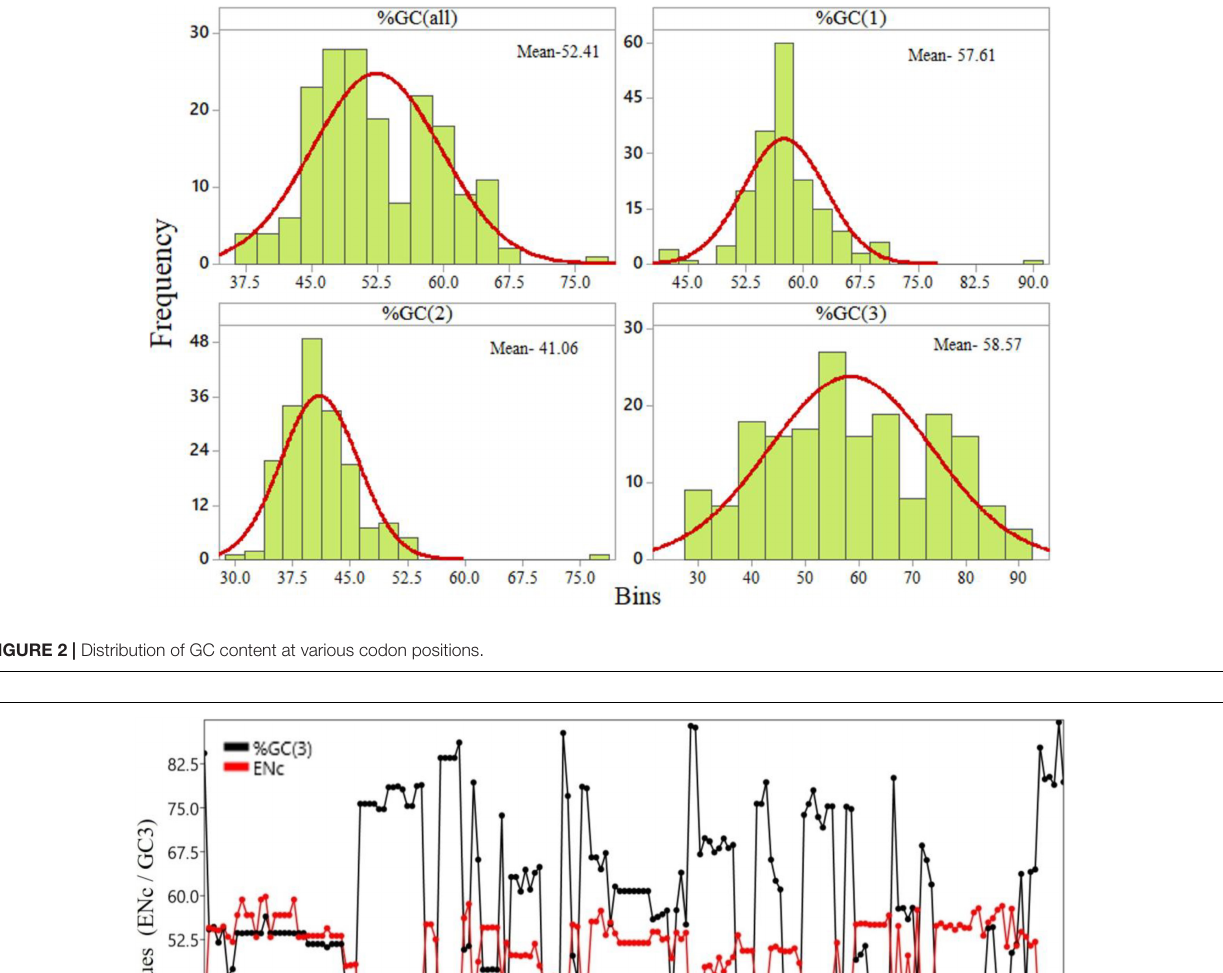
FIGURE 3 | Trend analysis of ENC and GC3